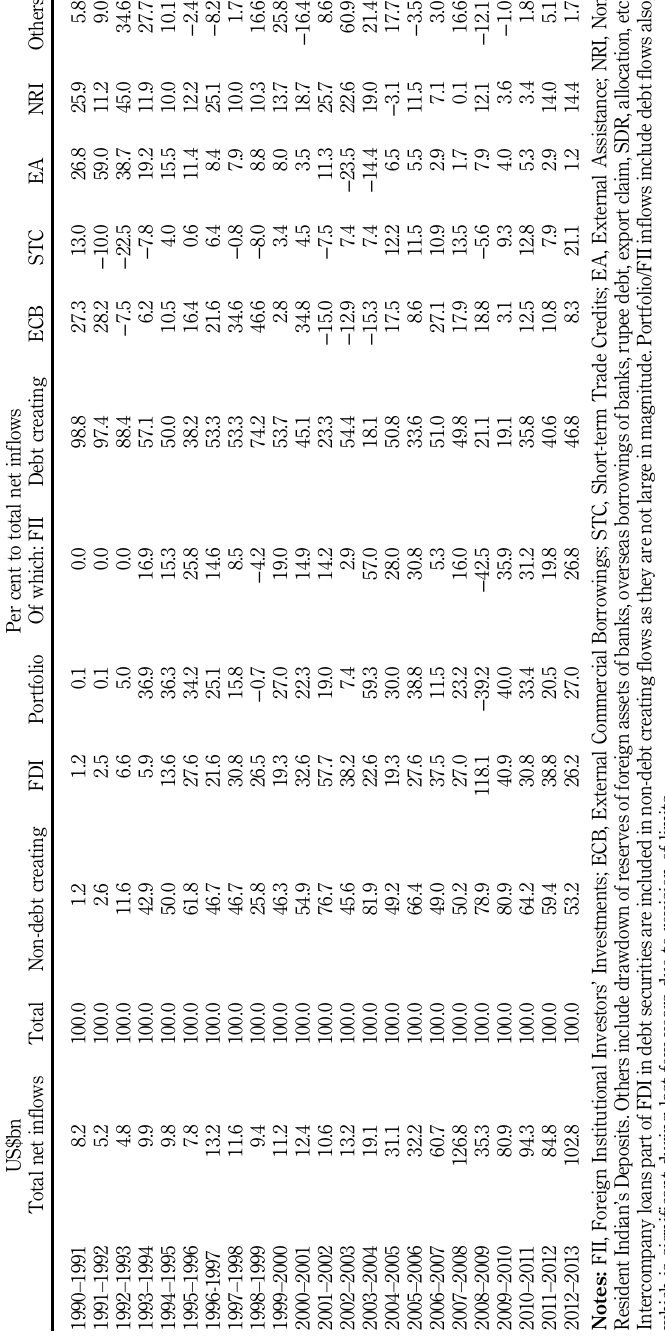
Table III. Composition of capital inflows to India